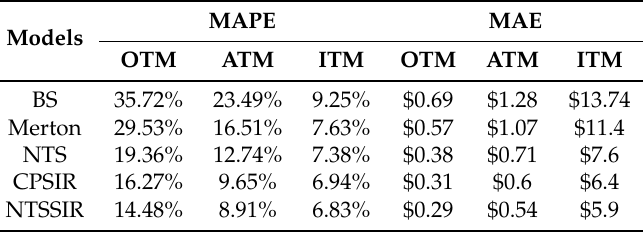
Table 3. Out-of-sample pricing errors. For a given model, we compute the price of each option on on 16 April 2020, using the parameters estimated in Table 1. The group under the heading MAPE reports the sample average of the absolute difference between the market price and the model price for each option in a given moneyness category; the group under the heading MAE reports the sample average of the value derived through dividing the MAE by the market